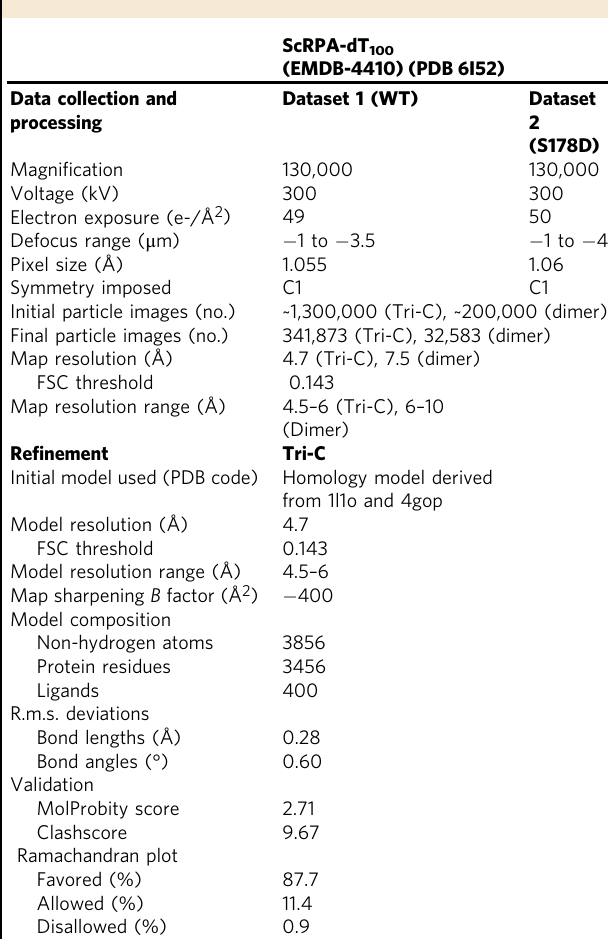
Table 1 Cryo-EM data collection, re fi nement, and